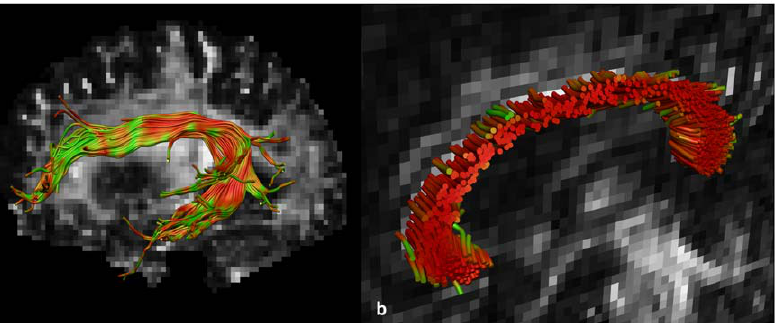
Figure 5. Crossing fiber regions reflected by the planar diffusion coefficient. The superior longitudinal fasciculus (SLF) and medial segment of the corpus callosum (CC) color coded according to the value of the planar diffusion coefficient (Cp) (for interpretation of the color coding see also fig. 3). The figure shows regions with ‘‘crossing fibers’’ reflected by a Cp close to one (green) and regions with relatively few ‘‘crossing fibers’’ reflected by a Cp close to zero (red). a) the SLF shows many regions with ‘‘crossing fibers’’ due to crossing with the cortico-spinal tract and/or laterally projecting fibers of the corpus callosum (CC) in frontal regions, and with the inferior longitudinal fasciculus in temporal regions. b) In the midsagittal segment of the CC one fiber population